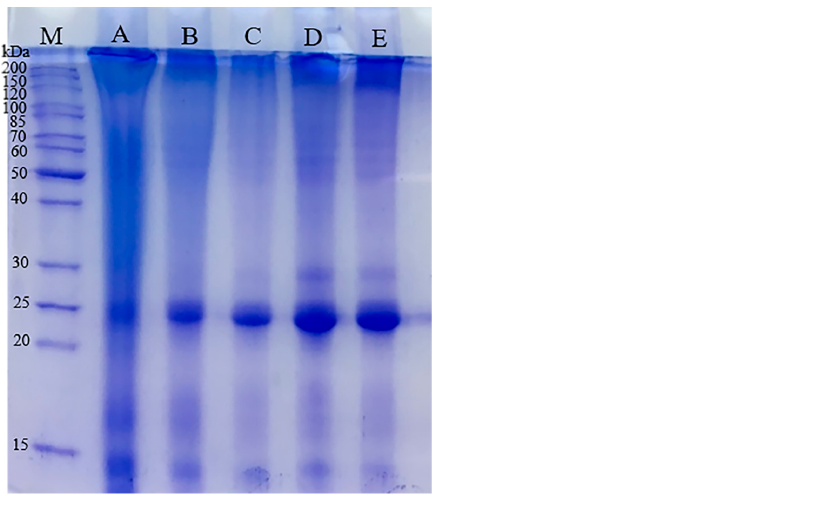
Figure 2. SDS-PAGE of SF/SS composite solutions. M: protein molecular weight standards; A: SF; B: SF/SS 4 ; C: SF/SS 3 ; D: SF/SS 2 ; E: SF/SS 1 .